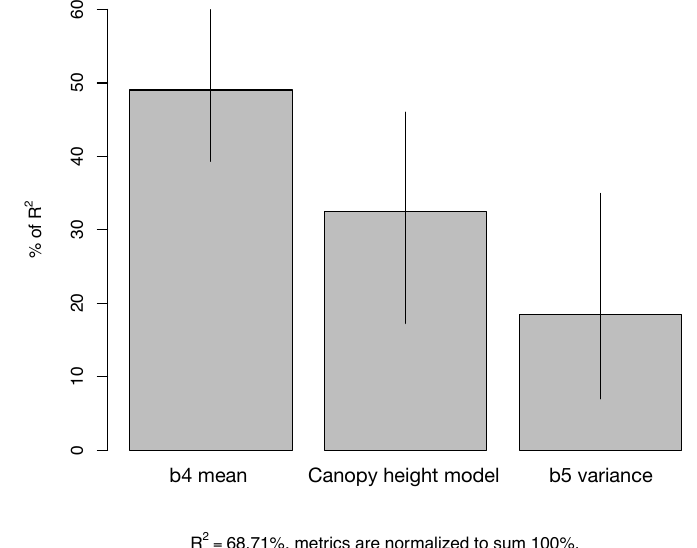
Figure 3. Relative importance for nMDS-1 with 95% bootstrap confidence intervals, b4 = redEdge band, b5 = infrared